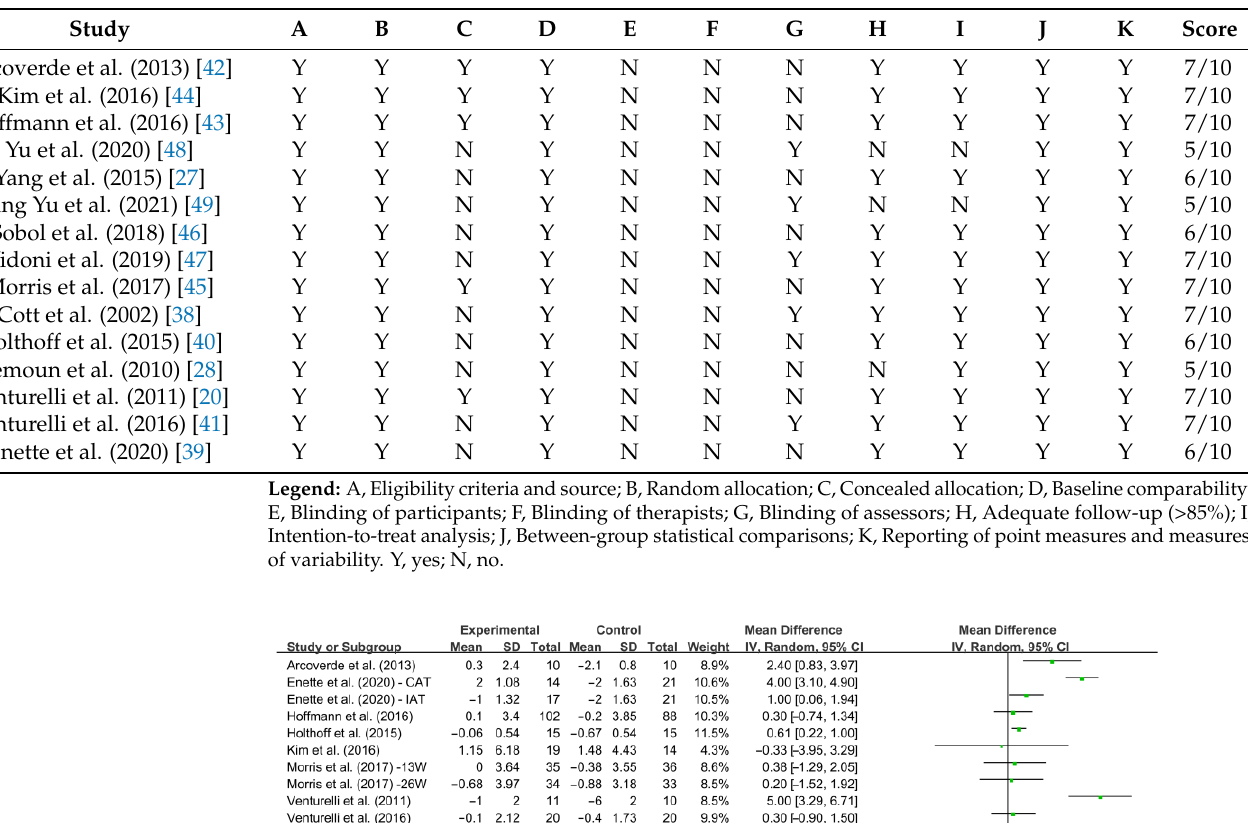
Table 2. Methodological assessment of randomized controlled trials included in the systematic review using the PEDro scale.